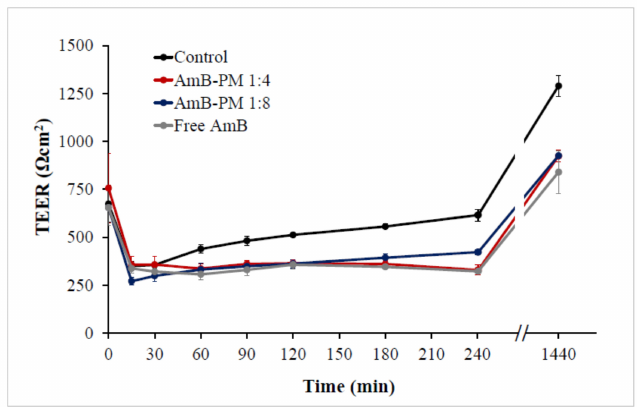
Figure 8. Transepithelial electrical resistance (TEER) values of Caco-2 cells after incubation with AmB-PM and free drug, immediately after the experiment or following 24 h recovery in standard growth media. ( n = 3).